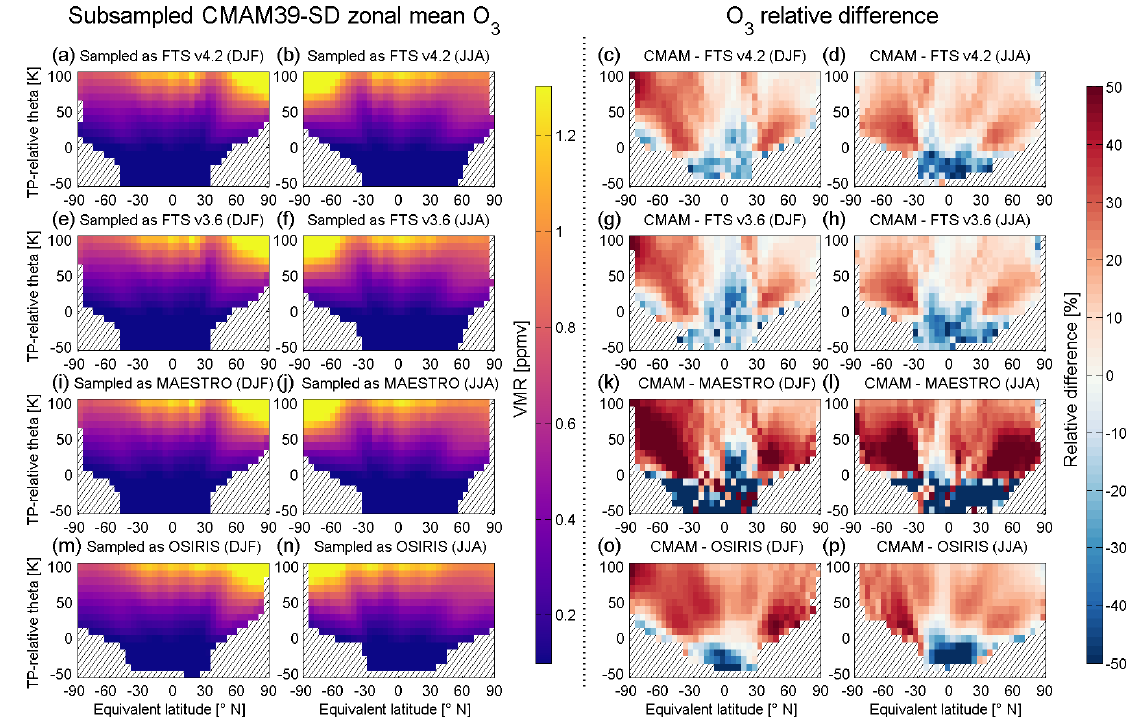
Figure 5. Same as Fig. 2 but for ozone and including an additional row (m–p) for climatologies constructed from the CMAM39-SD simulation subsampled to the location and time of the OSIRIS measurements and for the comparisons between these and the OSIRIS ozone